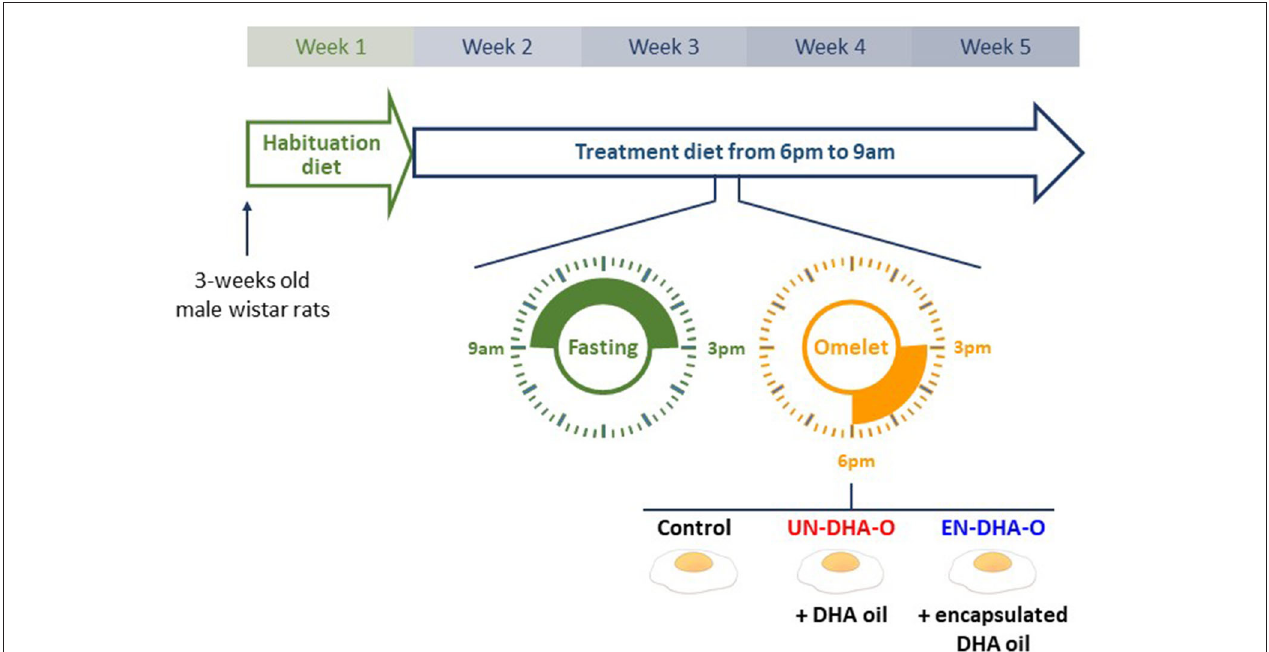
FIGURE 1 | The experimental design. Rats were acclimated with the habituation diet for one week. They were then fed with the treatment diet (T-diet) for four weeks. During this period, the rats were daily fasted for 6 hours before receiving 3g of omelet containing DHA as oil (UN-DHA-O) or as encapsulated oil (EN-DHA-O).